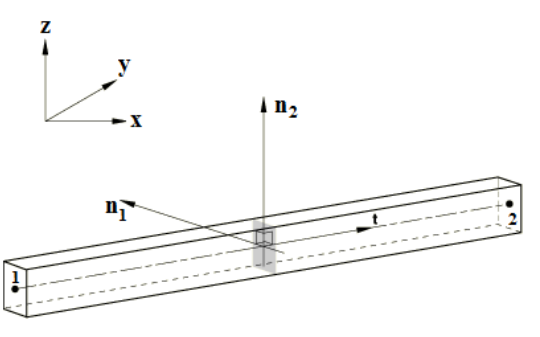
Fig. 1. Beam element in Abaqus library (Simulia, 2010).